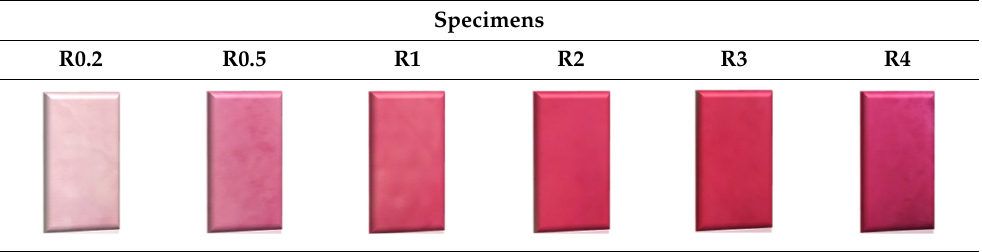
Table 7. Color parameters of specimens dyed with dye Disperse Red 15 (DR15).